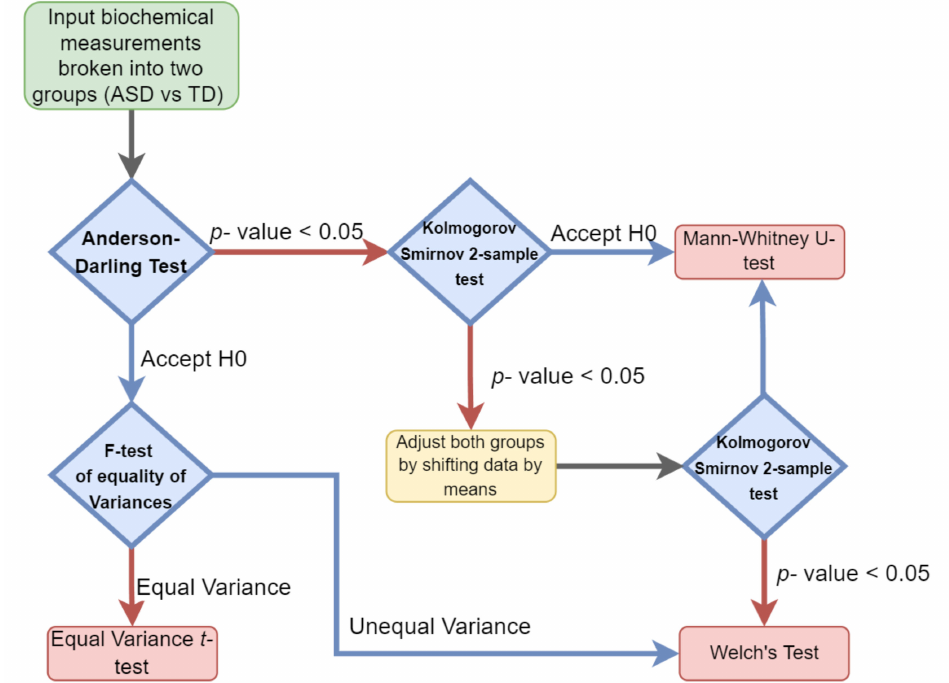
Figure 1. Univariate hypothesis test selection paradigm. Each sample set was examined for both its variance and distribution to select the appropriate parametric or nonparametric